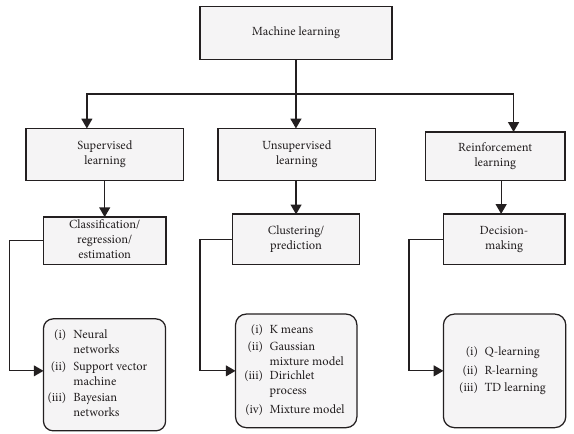
Figure 2: Machine learning